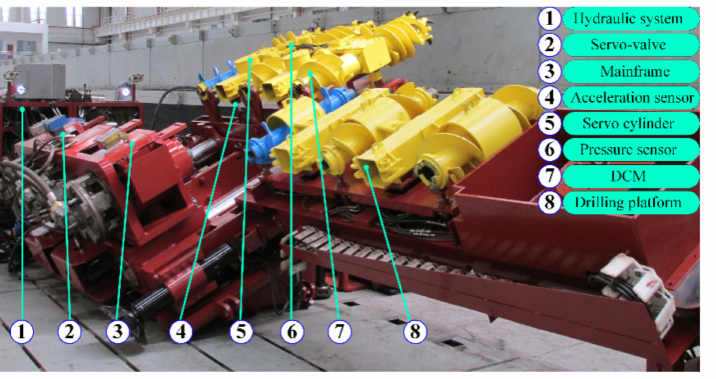
Figure 10. Experiment prototype for position deviation